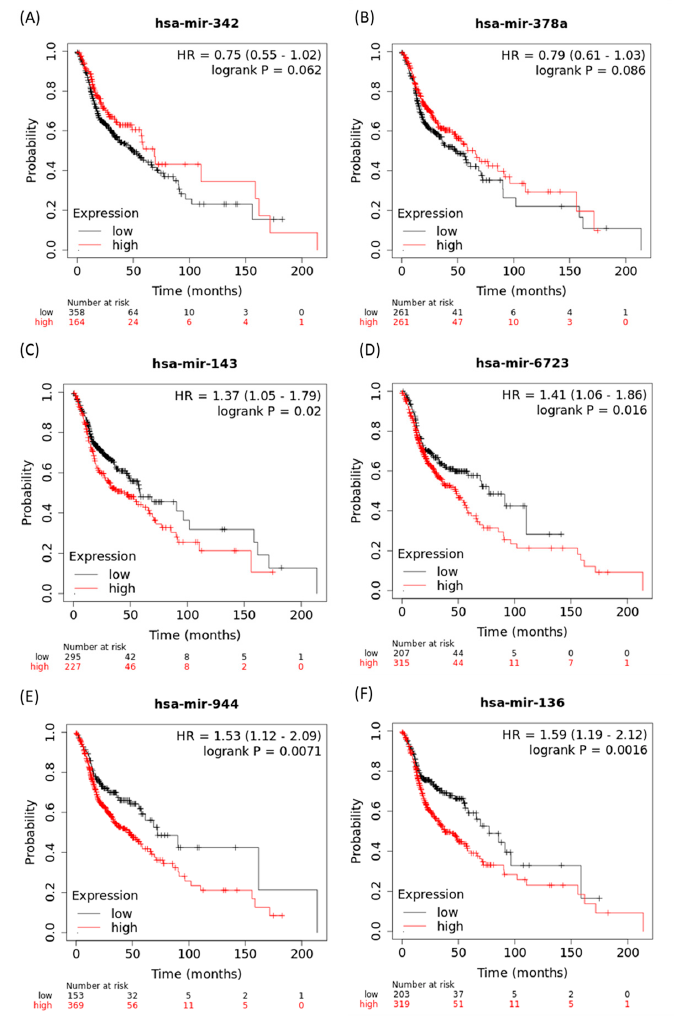
Figure 7. The association of 188 Re-liposome deregulated microRNAs with the survival rates of HNSCC patients. Kaplan–Meier (K-M) plot ( A ) hsa-miR-342; ( B ) hsa-miR-378a; ( C ) hsa-miR-143; ( D ) hsa-miR-6723; ( E ) hsa-miR-944; ( F ) hsa-miR-136.